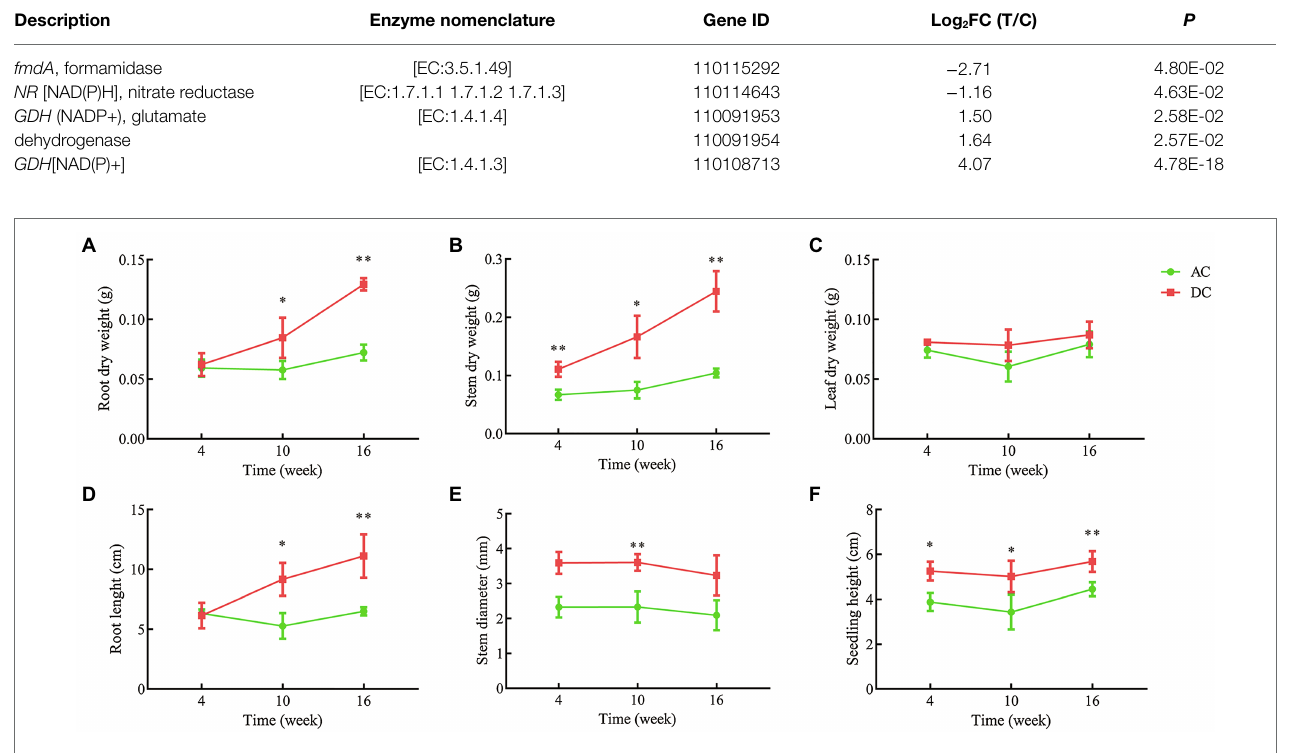
FIGURE 3 | Growth index of samples for validation. (A) Root dry weight. (B) Stem dry weight. (C) Leaf dry weight. (D) Root length. (E) Stem diameter. (F) Seedling height. AC, axenic culture and DC, dual culture. * p < 0.05; ** p < 0.01.